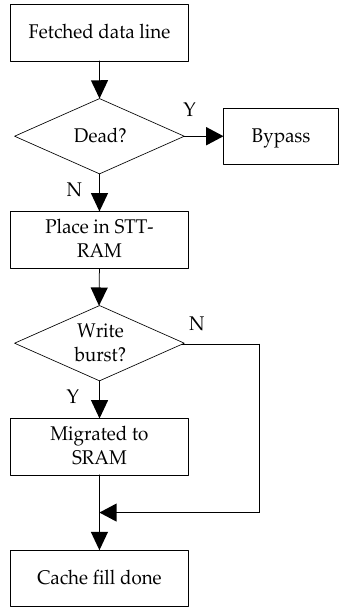
Figure 3. The optimization in cache fill.